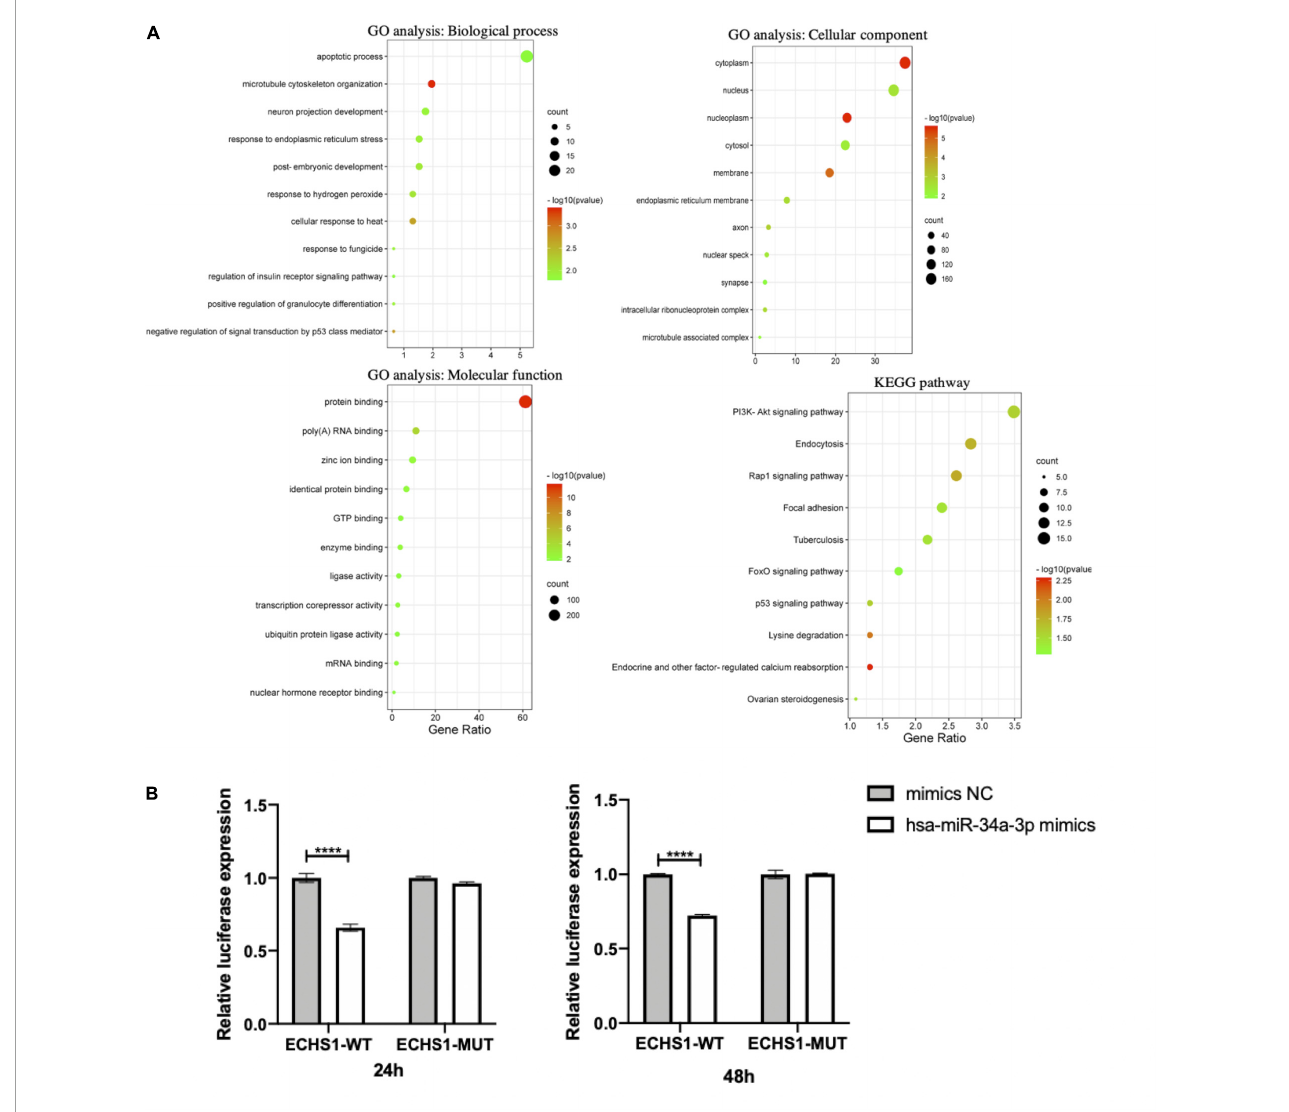
FIGURE5 The downstream prediction and validation of hsa-miR-34a-3p. (A) The functional analysis including GO and KEGG analyses of target genes predicted hsa-miR-34a-3p. (B) Preliminary validation of putative target gene ECHS1 of hsa-miR-34a-3p by Dual-Luciferase reporter assay. The result showed that hsa-miR-34a-3p bound to ECHS1 at both 24 h ( p = 0.0001) and 48 h ( p < 0.0001) and caused a statistically significant decrease in fluorometric intensity. ∗∗∗∗ p <